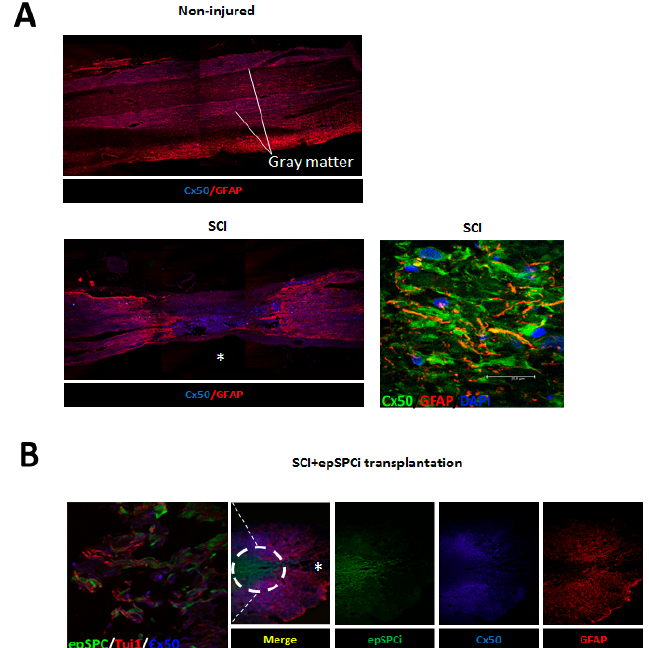
Figure 3. Cx50 expression in healthy spinal cord tissue, after SCI, and epSPCi transplantation. Immunohistochemical evaluation of Cx50 and the astrocytic marker GFAP in tissues from ( A ) non-injured spinal cord and 2 months after SCI (Zoom; Cx50/GFAP/DAPI); Scale bar = 25 µm, and ( B ) 2 months after SCI with GFP-epSPCi transplantation (Zoom; epSPCi/TuJ1/Cx50); *